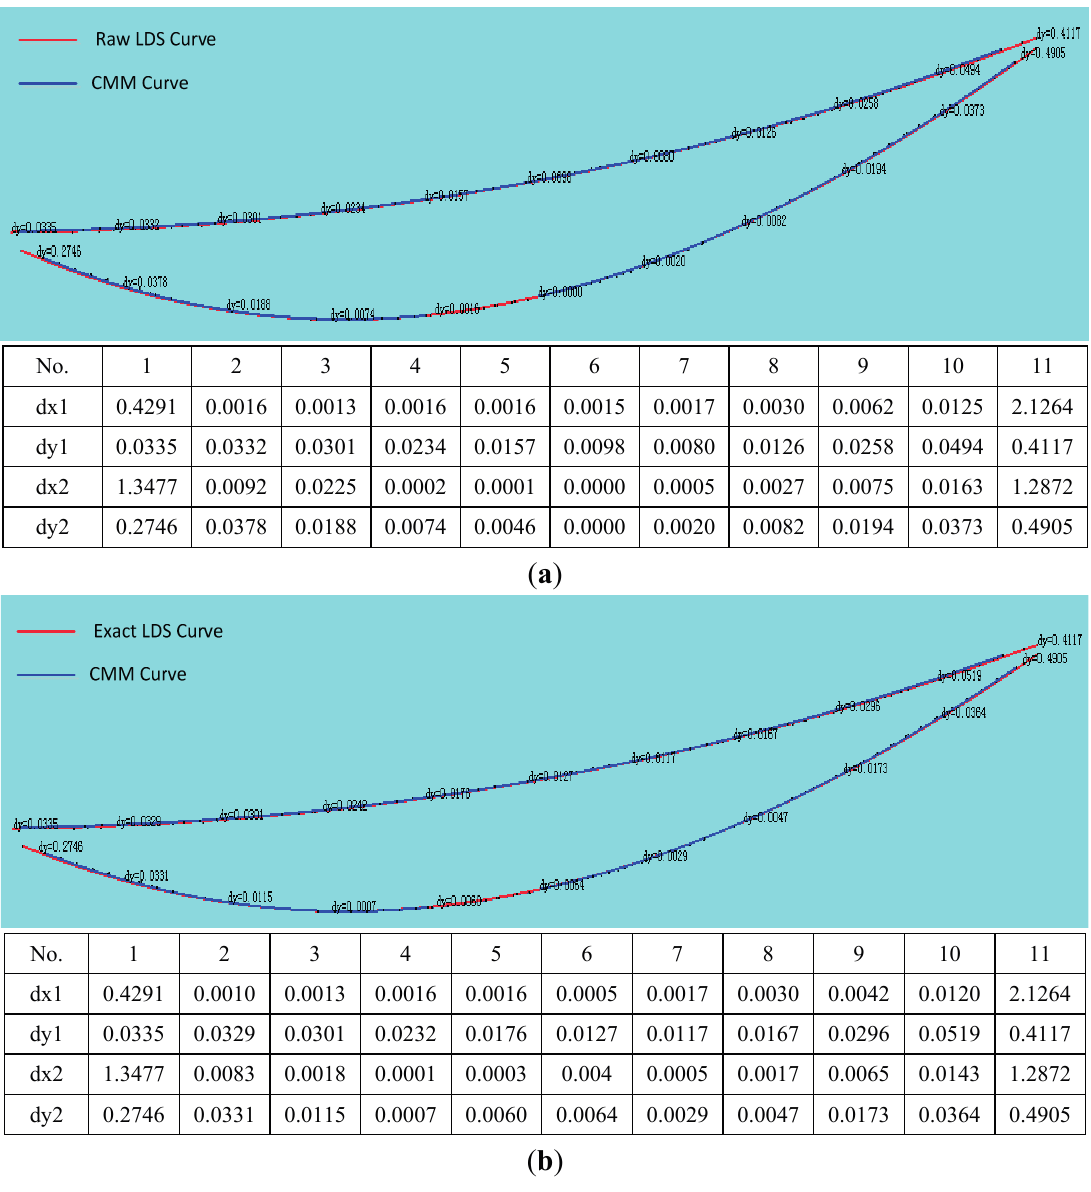
Figure 16. Curve deviation assessment. ( a ) Curve deviation assessment before compensation and data sheet; ( b ) Curve deviation assessment after compensation and data